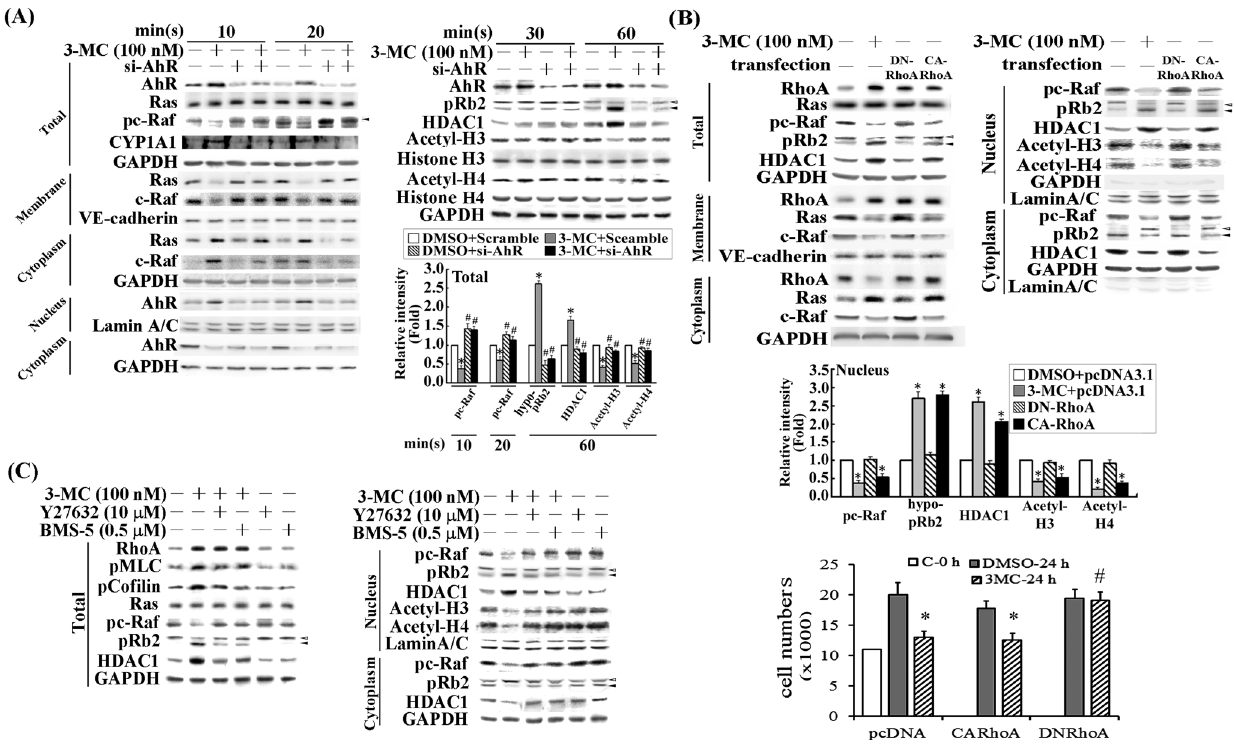
Figure 3. Essential role of AhR/RhoA activation in pRb2/HDAC1 upregulation and nuclear translocation induced by 3MC in MCVECs. Cells were transfected with siAhR (A), DNRhoA, or CARhoA (B) overnight, with or without 3MC treatment for 1 h and separated into membrane, cytosolic and nuclear fractions. Western blot analysis was used to examine Ras/c-Raf cytosolic-membrane distribution and AhR/pRb2/ HDAC1 cytosolic-nuclear distribution by cellular fractionation. The effects of DNRhoA and CARhoA in cell proliferation were assessed by counting the cell numbers using a hemo-cytometer. Data are presented as mean 6 SEM of 3 independent experiments. (C) Cells received a 1 h pretreatment with a ROCK inhibitor (Y27632) or a LIMK inhibitor (BMS-5), followed by 1 h of the 3MC challenge; the cells were then harvested and partitioned into nuclear and cytosolic fractions. Phosphorylation of myosin light chain and cofilin were used as positive controls for the actions of Y27632 and BMS-5, respectively. GAPDH, Lamin A/C, and VE-cadherin were used as internal controls for the cytosol, nuclear and membrane fractions, respectively, to verify equivalent loading. Representative results of 3 separate experiments are shown, and data are presented as the mean 6 SEM (* P , 0.05 vs. control or DMSO group; # P , 0.05 vs. 3MC treatment